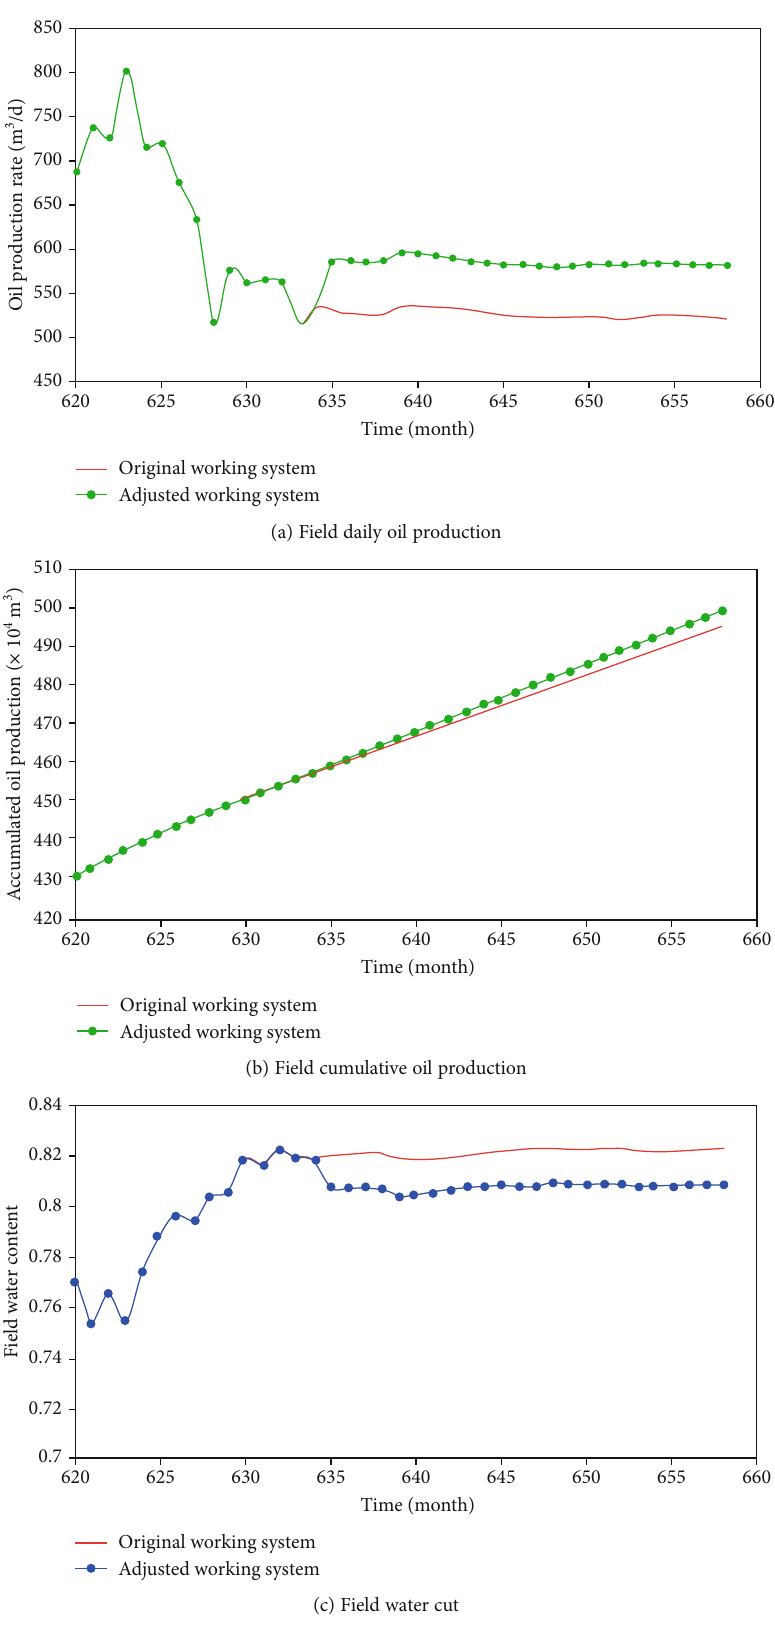
Figure 20: The comparison of adjustment e ff